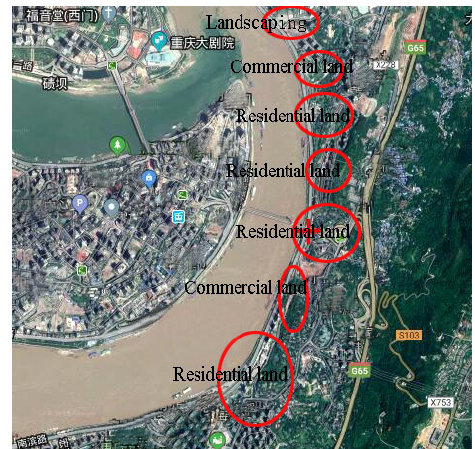
Figure 3. Functional layout of land use along the river.